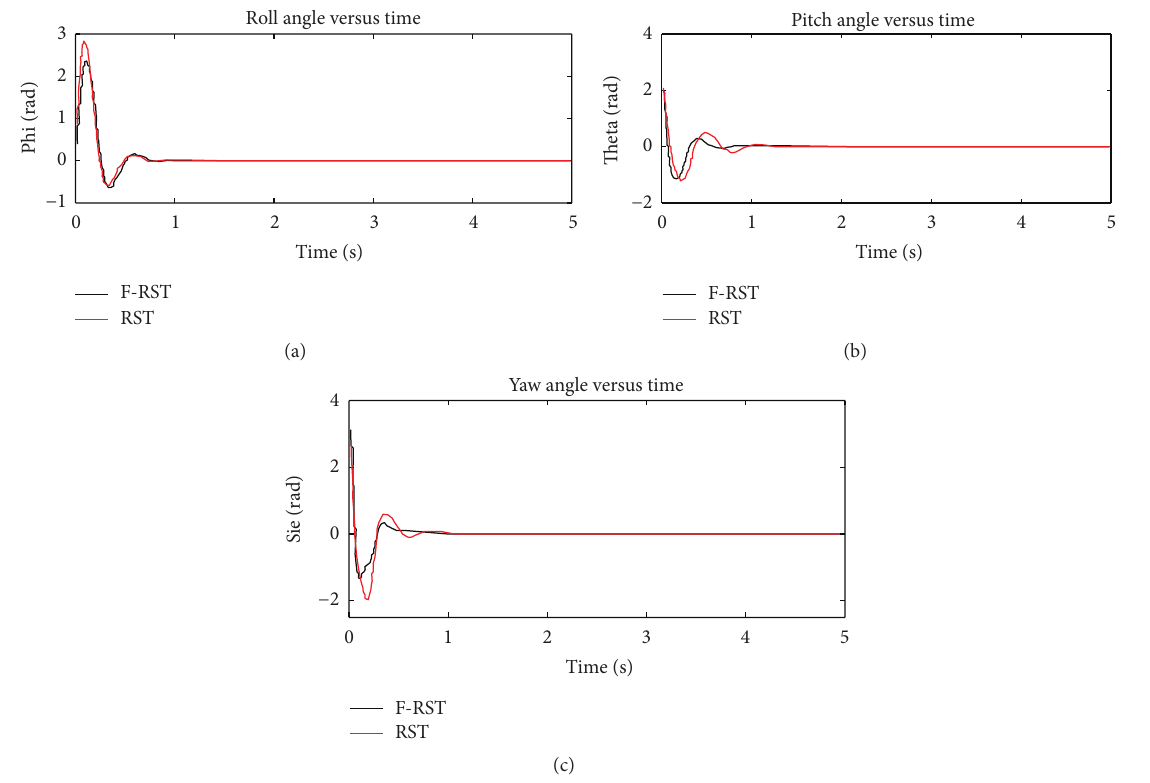
Figure 16: Comparison of F-RST with RST controller for Euler angle responses.